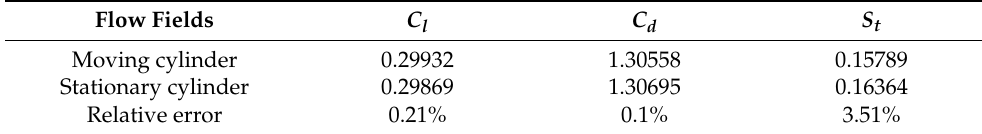
Table 1. C l , C d , and S t corresponding to the two flow